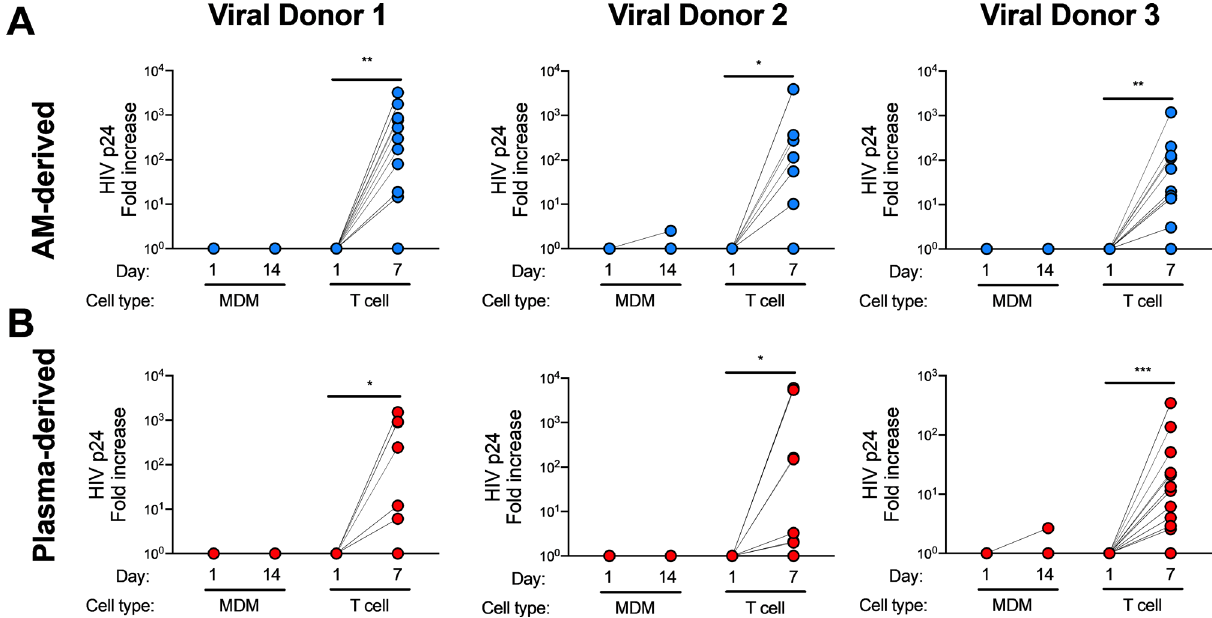
Figure 2. AM- and plasma-derived HIV primary isolates are T-tropic. HIV env isolated from AMs or plasma from 3 HIV-infected donors was cloned into an HIV NL4-3 env deleted backbone plasmid. Replication- competent virus was added to activated CD4+ T cells or MDMs for 12 h and washed, and supernatant was collected 1 h after washing (Day 1) and after 7 or 14 days. Data is shown as fold change of HIV p24 in supernatant at the final timepoint (Day 7 for T cells, Day 14 for MDMs) compared to Day 1. Cells were infected with AM-derived viral isolates ( A ) from viral donor 1, 2 or 3 or plasma-derived viral isolates ( B ) from viral donor 1, 2 or 3. Data from all viral isolates from the same viral donor and anatomical site were pooled. CD4 + T cells and MDMs were isolated from six HIV-uninfected blood donors. In ( A ), n = 12 (6 cell donors infected with 2 viral isolates) for viral donor 1, n = 18 (6 cell donors infected with 3 viral isolates) for viral donor 2, and n = 18 (6 cell donors infected with 3 viral isolates) for viral donor 3; in ( B ), n = 12 (6 cell donors infected with 2 viral isolates) for viral donor 1, n = 12 (6 cell donors infected with 2 viral isolates) for viral donor 2, and n = 30 (6 cell donors infected with 5 viral isolates) for viral donor 3. Statistics by Kruskal–Wallis test. * p < 0.05, ** p < 0.01, *** p <